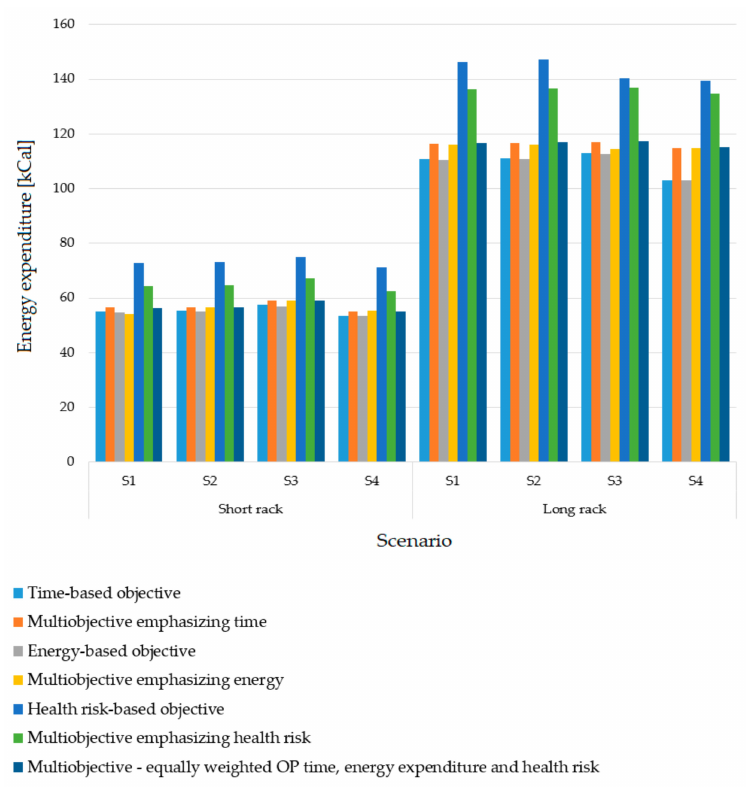
Figure 10. Comparisons of energy expenditures from different objective